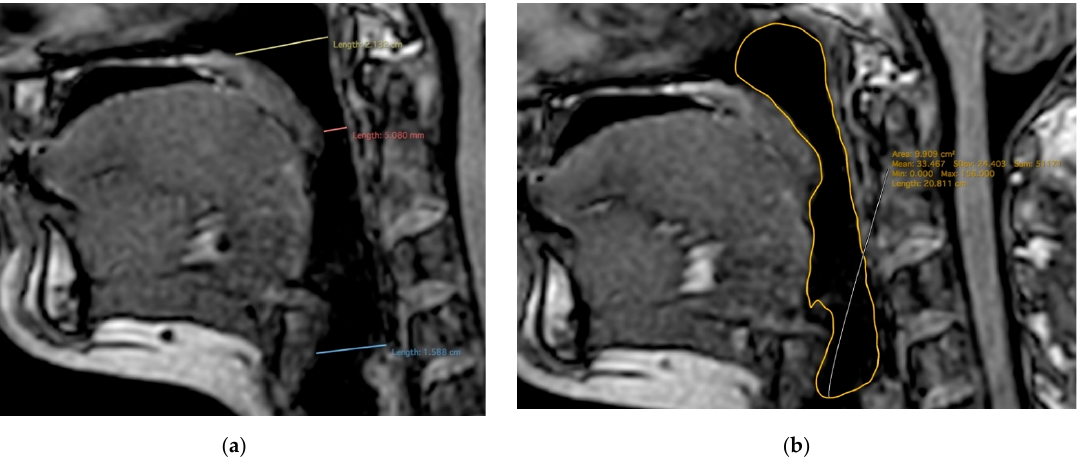
Figure 2. T1 weighted measurements of the posterior airway space on midsagittal plane ( a ) nasal (yellow), occlusal (orange) and mandibular (blue) thickness; ( b ) area (yellow curve).